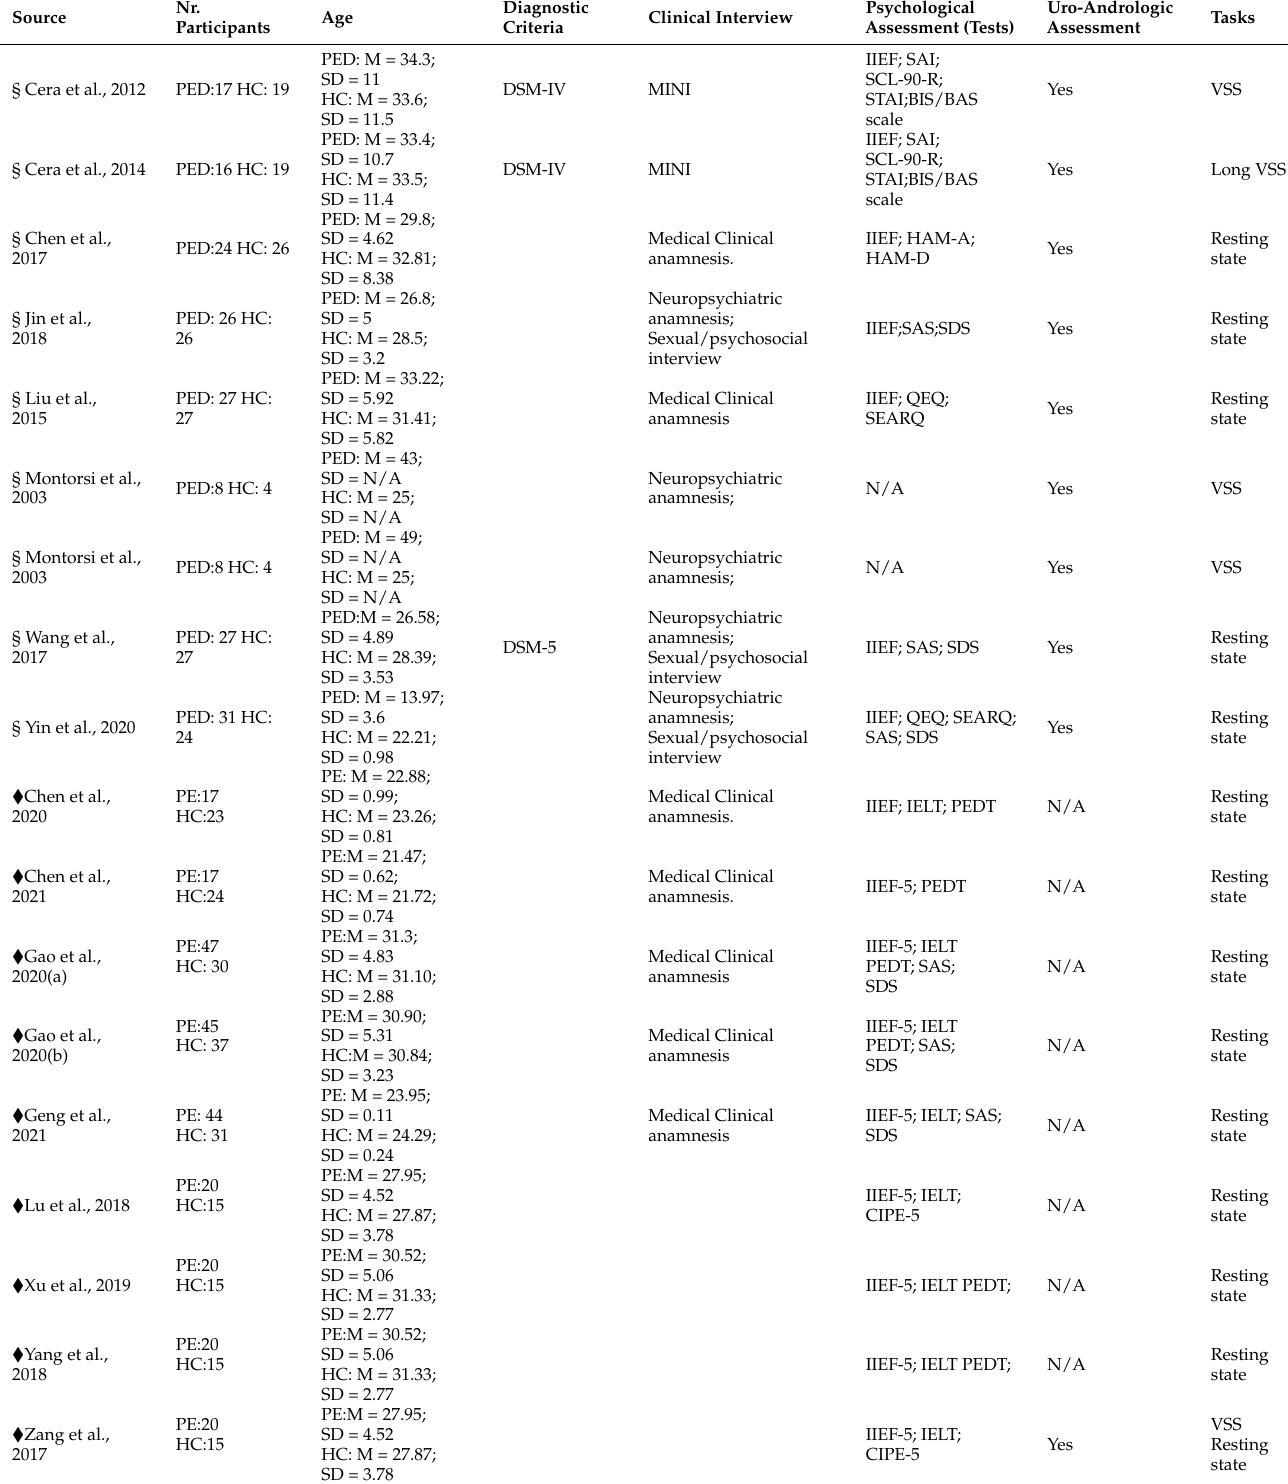
Table 3. Sociodemographic characteristics, diagnostic criteria and tasks as reported in the included